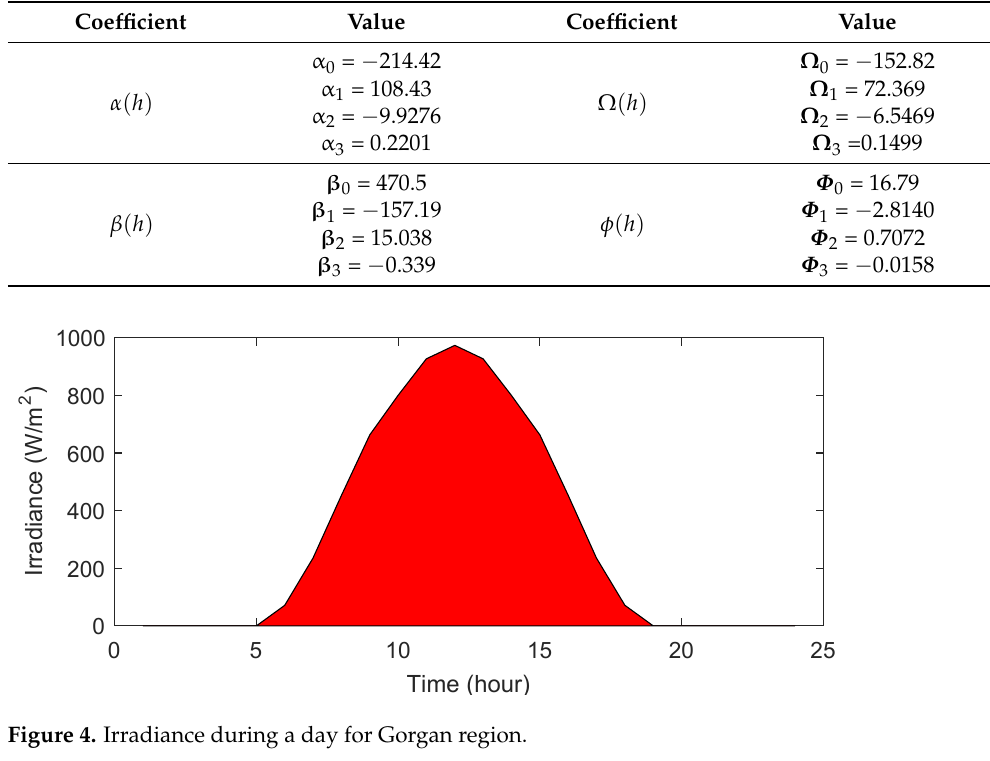
Figure 5. Irradiance during a day for Gorgan region.